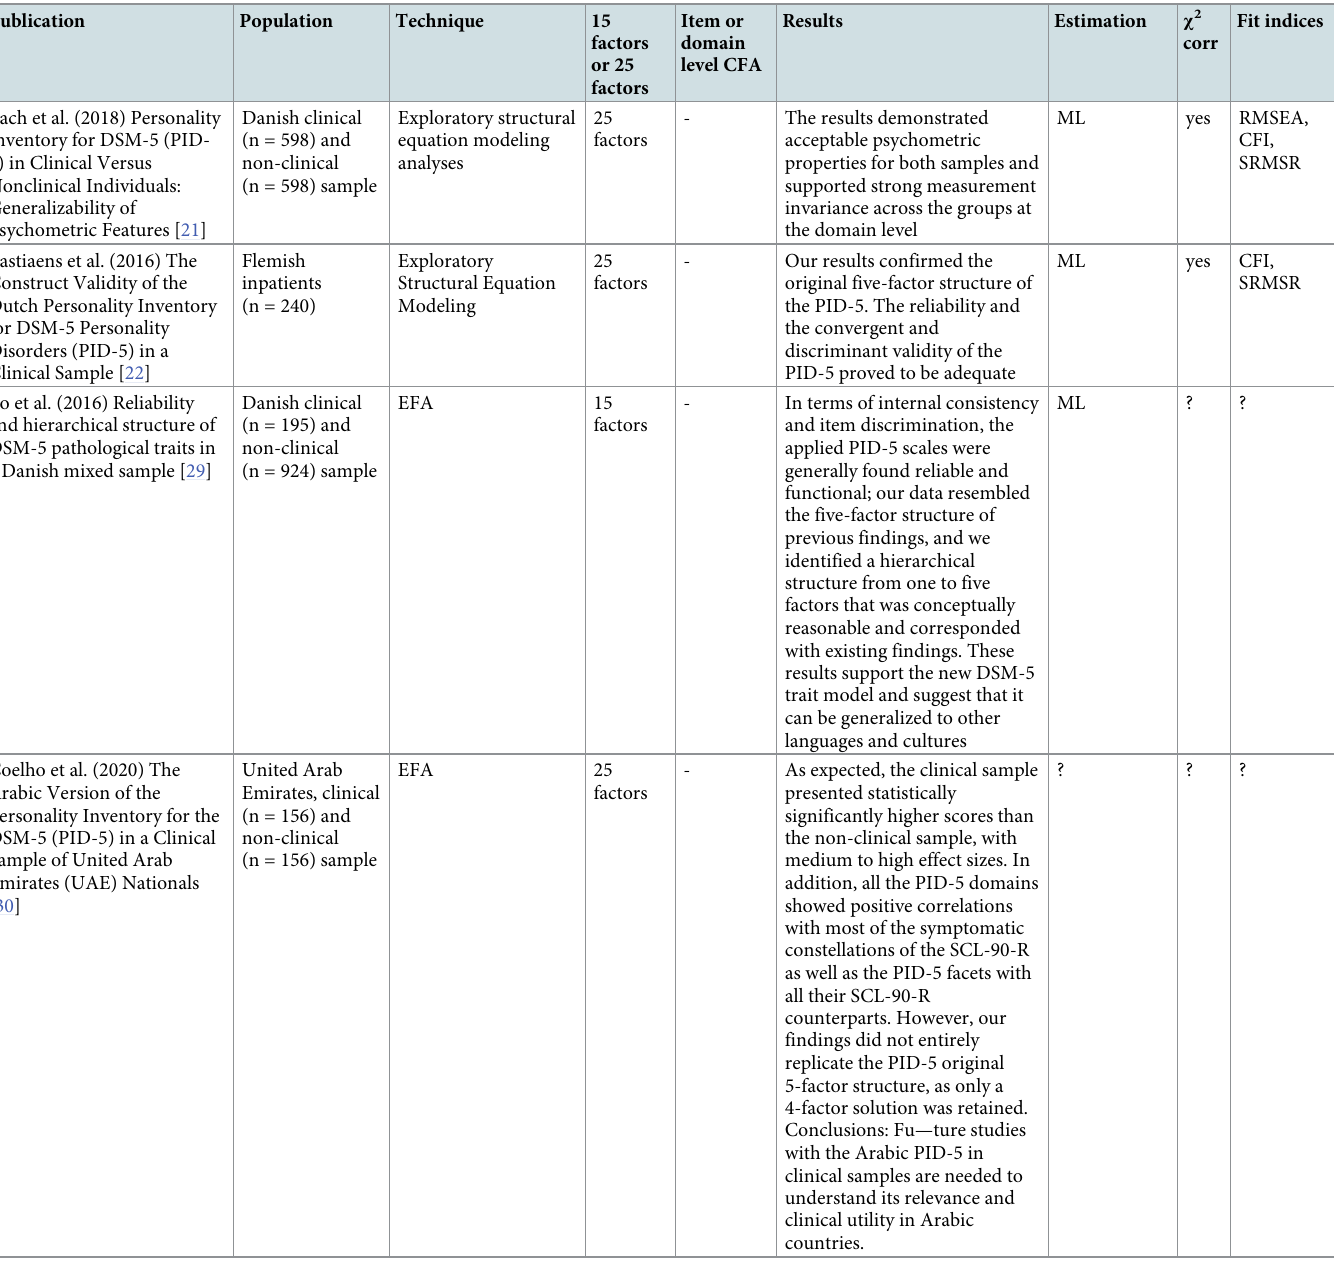
Table 2. Overview of methods for studies examining the psychometric properties of PID-5 with exploratory or confirmatory factor